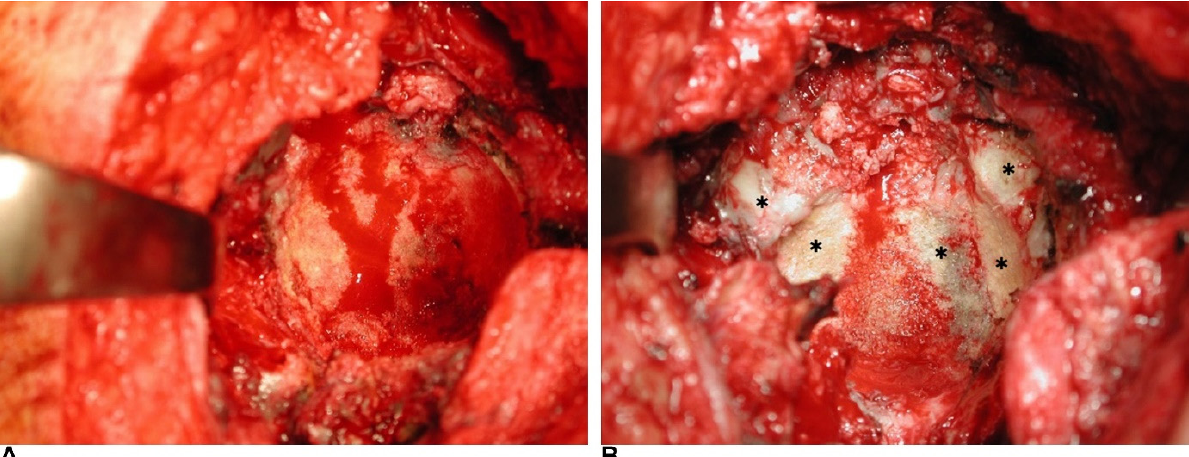
Figure 1. ( A ) The host bone of acetabulum was bleeding after reaming in re-revision surgery, indi- cating revascularization of allografts. ( B ) The allografts, which were implanted in index revision, had non-vascularized areas (marked with *) during re-revision